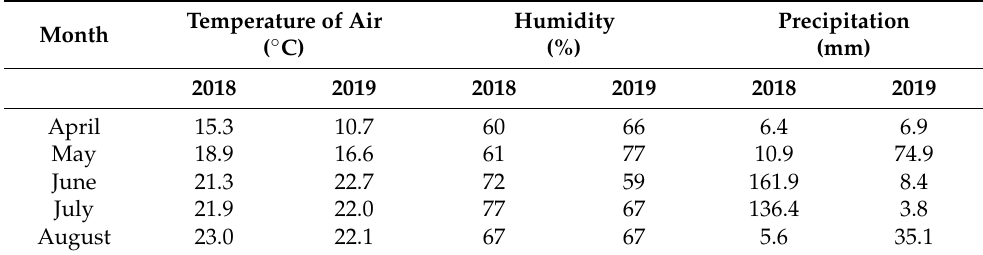
Table 1. The meteorological conditions during the